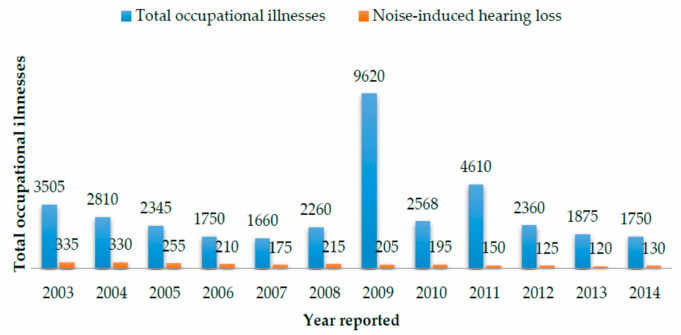
Figure 3. Occupational illnesses reported in the United